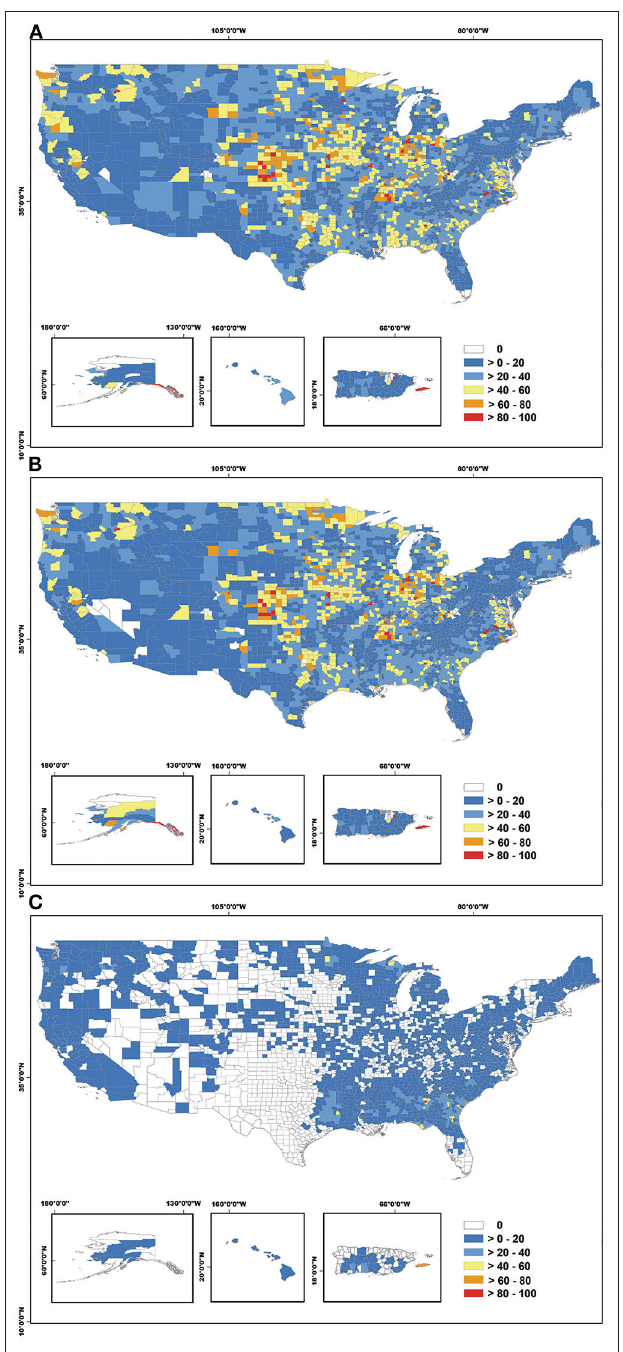
FIGURE 5 | Choropleth maps representing the percentage of total EQIP investments from 2009 to 2018 dedicated to practices that were categorized as having the greatest potential to improve soil health, transition to ecologically-based management, and expand adaptive strategy that were also executed in-situ on managed lands. (A) depicts the percent of total EQIP investments dedicated to Level 3 , (B) depicts the percent of total EQIP investments dedicated to Quadrant 4 , and (C) depicts the percent of total EQIP investments dedicated to Transformation